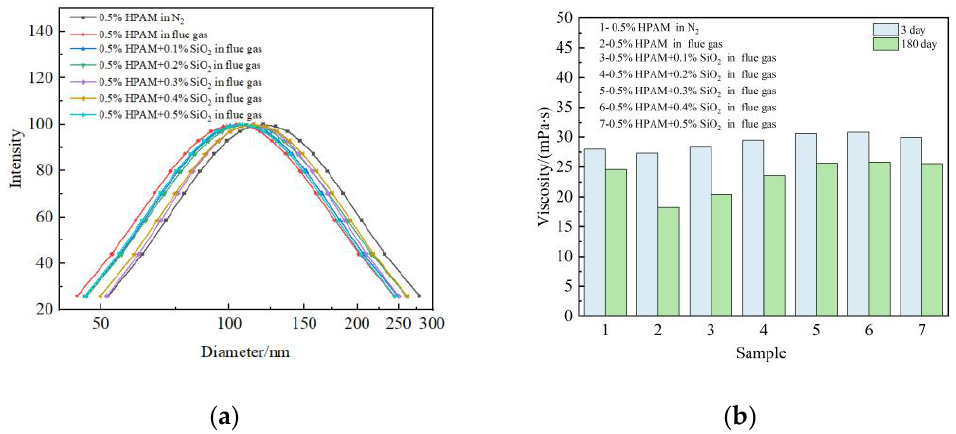
Figure 4. Effect of nano-SiO 2 on polymer properties: ( a ) Hydrodynamic radium (R h ); ( b ) Viscosity.